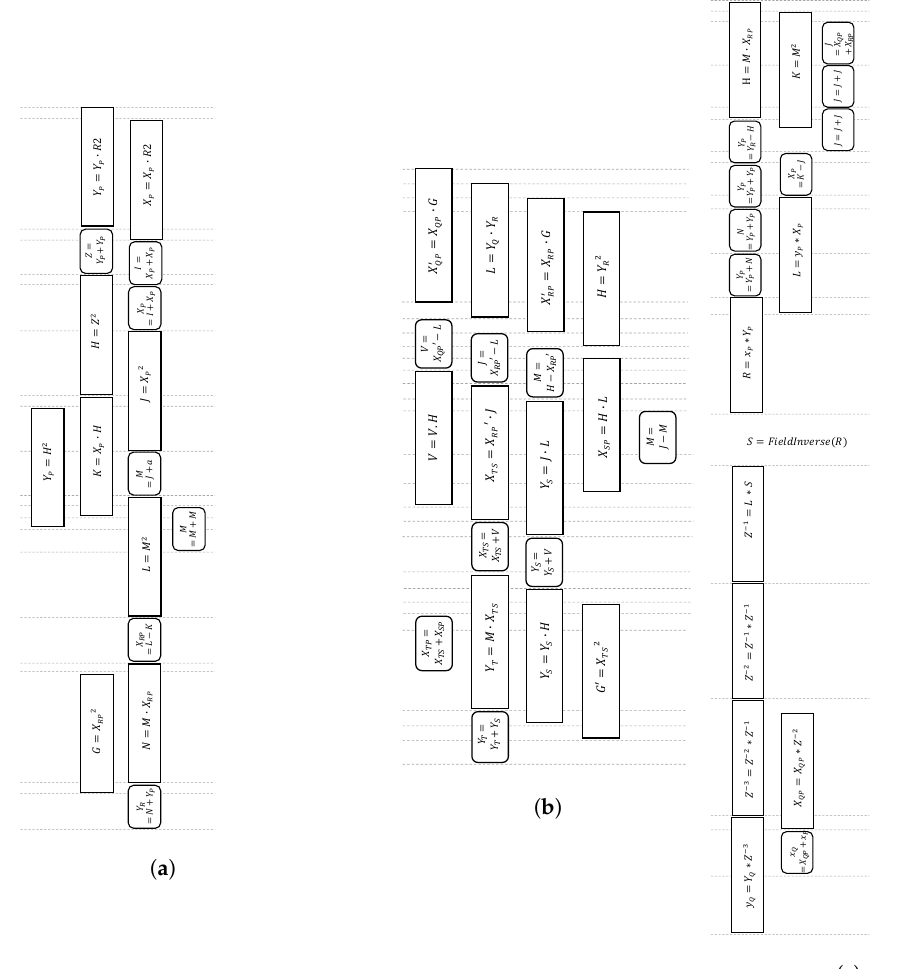
Figure 8. Proposed scheduling for Montgomery ( a ) ladder setup; ( b ) ladder update; and ( c ) ladder